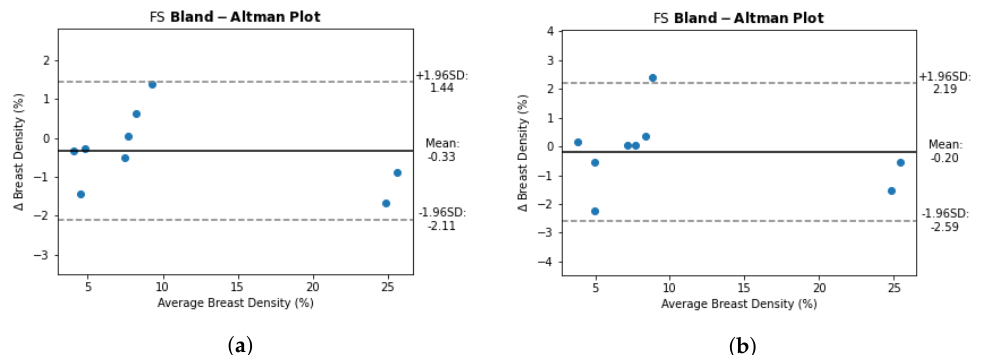
Figure 4. Bland–Altman plot to compare the breast density (BD) calculated on ground truth manual annotation and BD calculated from breast and FGT segmentations generated by the network trained with WOFS + FS acquisitions. ( a ) Bland–Altman plot for WOFS test cases. ( b ) Bland–Altman plot for FS test